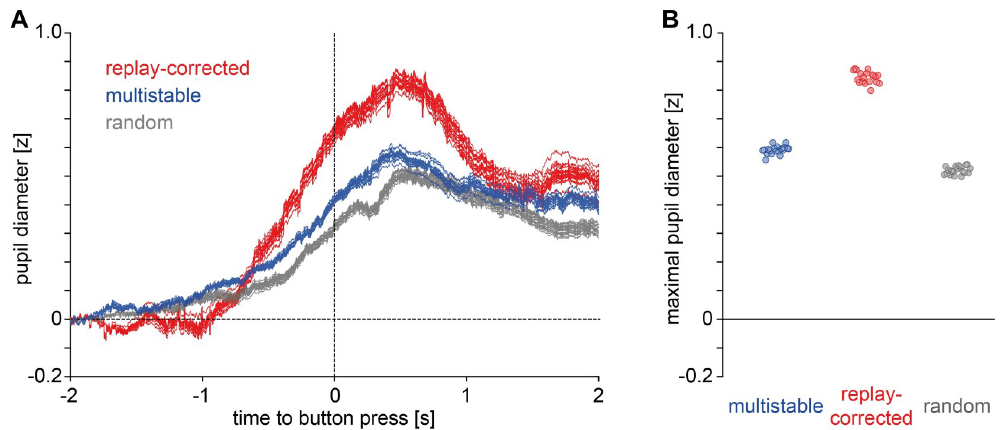
Fig 8. Jackknifing analysis of pupil dilation, Study 2. A ) Jackknifed traces (19 per condition) and B ) maximal amplitudes of the jackknifed traces. replay-corrected conditions ( t (18) = 2.44, p = .025), and no significant difference corrected